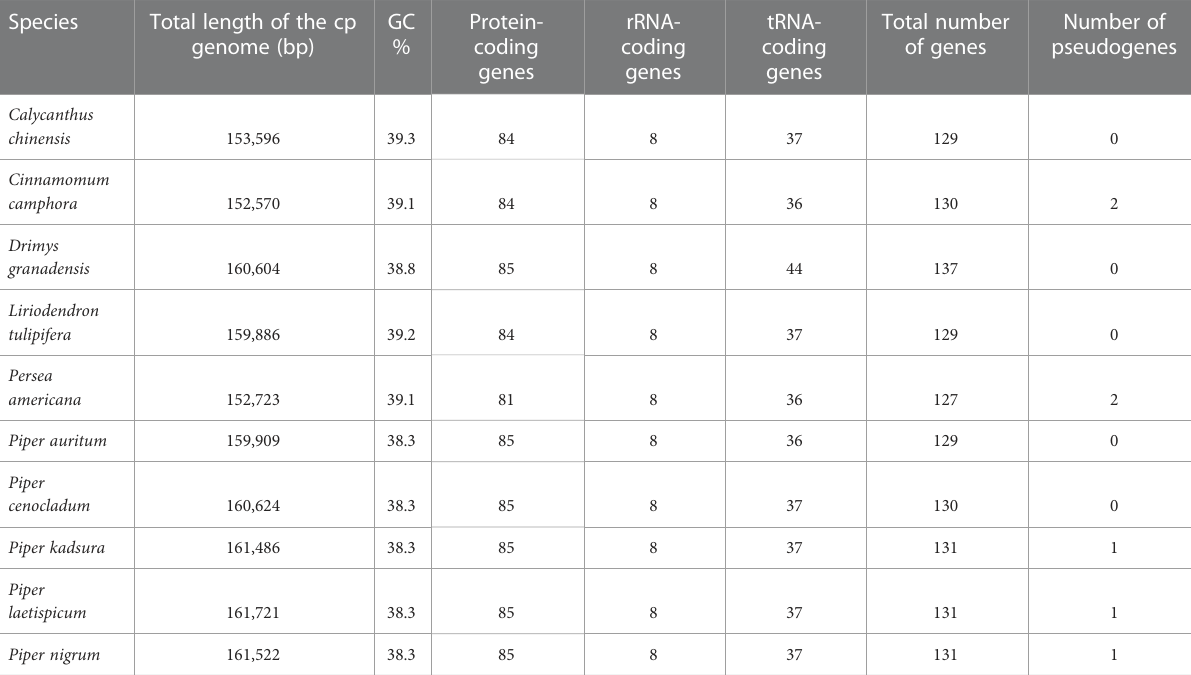
TABLE 4 Gene content comparison of Piper nigrum chloroplast with reported Piper species and other